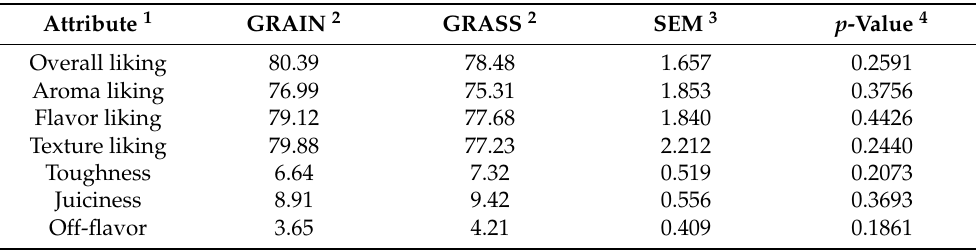
Table 7. Least square means for the effect of finishing system on subjective meat quality attributes rated by a consumer sensory panel ( n =113